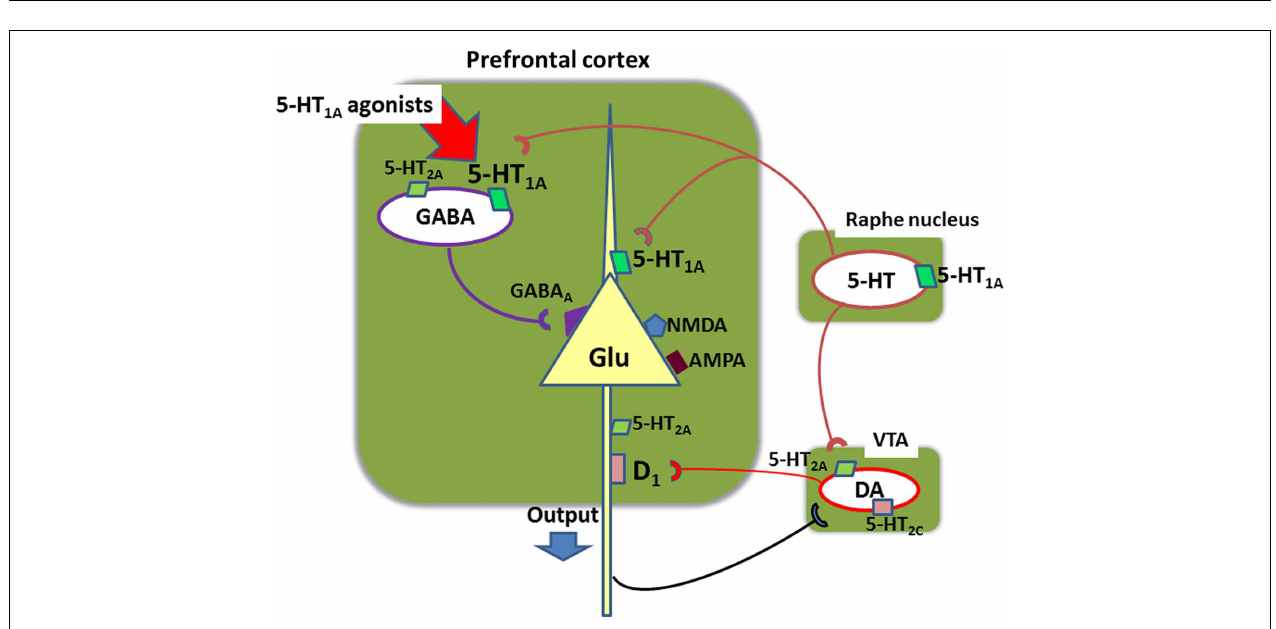
clozapine, a 5-HT 1A agonist, increases extracellular DA concentrations in the prefrontal cortex in mice, but it does not occur in mutant mice lacking 5-HT 1A receptors (Bortolozzi et al., 2010).These neural events may explain the ability of augmentation therapy with tandospirone to restore mismatch negativity amplitudes (Higuchi et al., 2010), an electrophysiological measure of glutamatergic activity that is diminished in schizophrenia.VTA, ventral tegmental